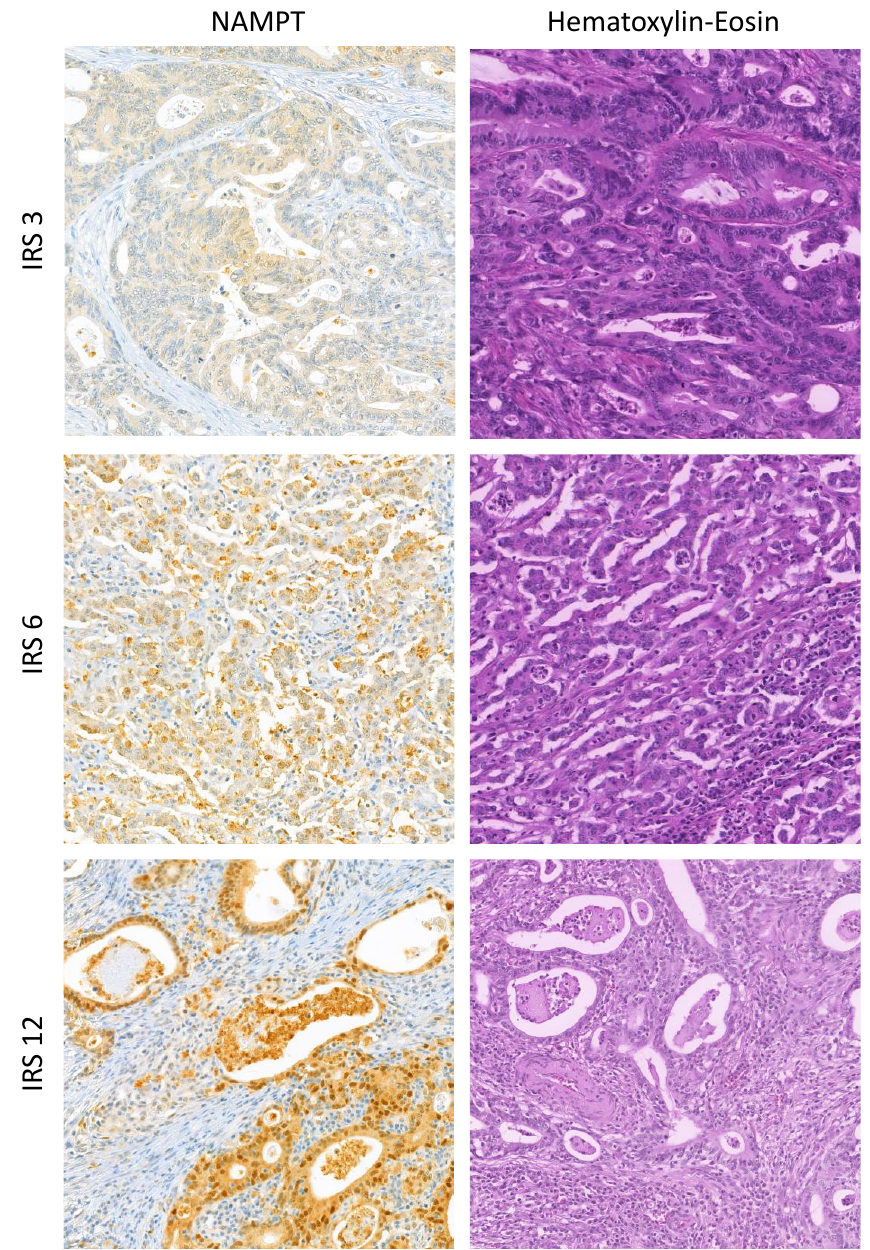
Figure 2. Representative NAMPT Staining of TMA cores. Examples of tumor samples with IRS = 3, 6, and 12 (40 × magnitude).